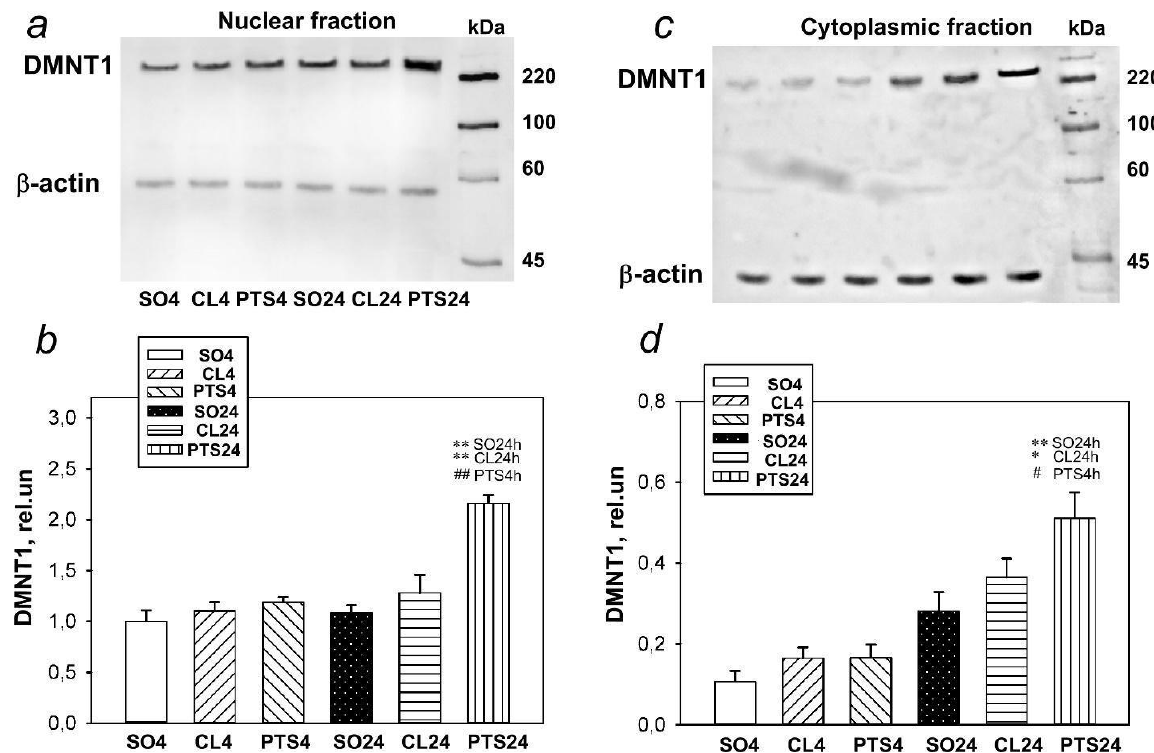
Figure 1. The expression of DNMT1in nuclear ( a , b ) and cytoplasmic ( c , d ) fractions of penumbra tissue at 4 or 24 h after photothrombotic stroke (PTS) in the rat cerebral cortex. The significant differences * p < 0.05 and ** p < 0.01 compared to sham-operated animals (SO) or contralateral cerebral cortex of the same animals (CL4 and CL24), # p < 0.05 and ## p < 0.01 compared to the PTS4 are shown. One-way ANOVA. M ± SEM. n = 7. Rel.un—the ratio of the optical density of the strip of the protein studied to the optical density of the strip of the protein load marker